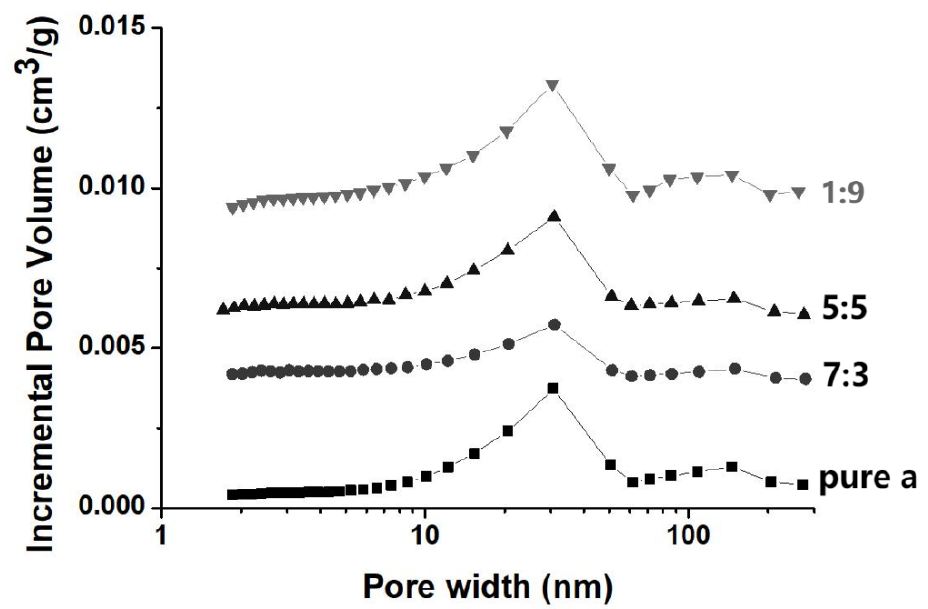
Figure 5. Pore size distribution of the pollen-like anhydrous lactose with tailored α / β ratios. Table 1. Pore features and loading efficiencies of the pollen-like anhydrous lactose with tailored α/β ratio.